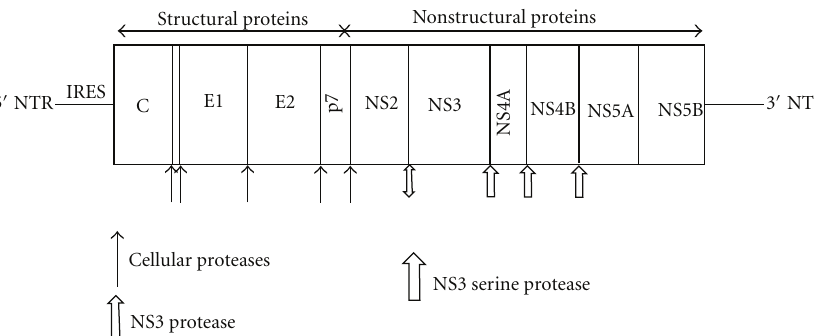
Figure 1: HCV genome and polyprotein cleavage products. A schematic representation of the HCV genome indicating the structural and nonstructural regions, including the 5 (cid:3) and 3 (cid:3) NTRs. The polyprotein cleavage products are drawn within. The cleavage site and the corresponding protease are indicated